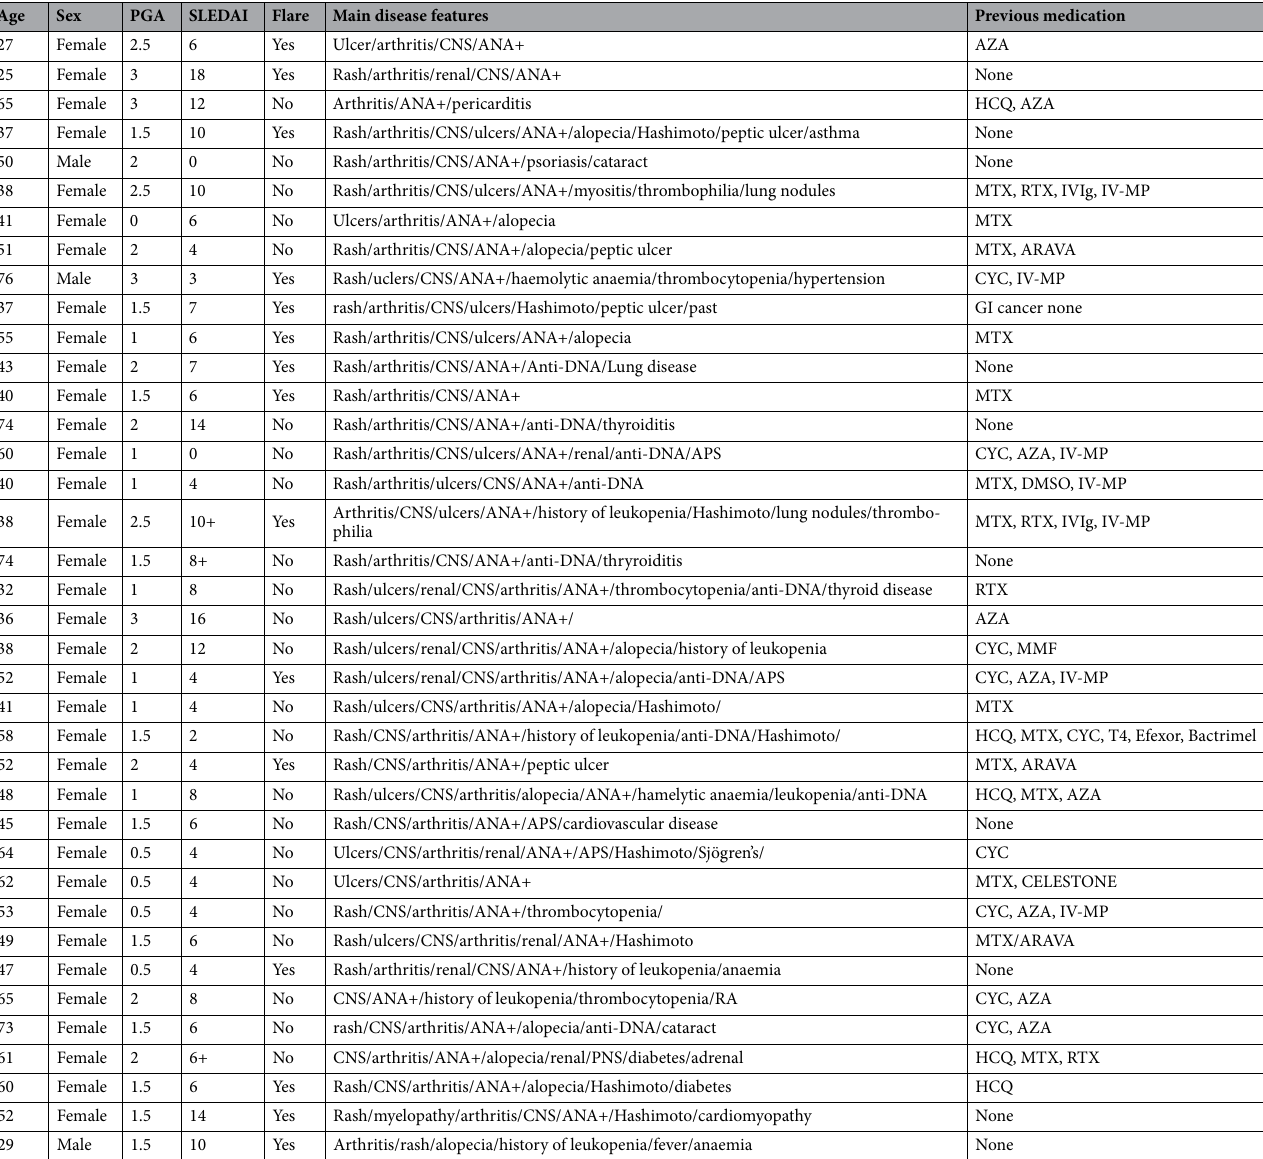
Table 1. Demographic and clinical characteristics of human SLE subjects at the time peripheral blood was obtained. HCQ hydroxychloroquine, PZ prednisone, AZA azathioprine, MTX methotrexate, RTX rituximab, central nervous system, RA rheumatoid arthritis, PGA physician global